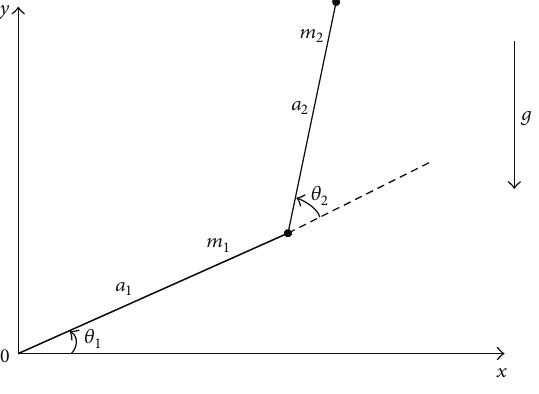
Figure 1: Two-link (RR) robot